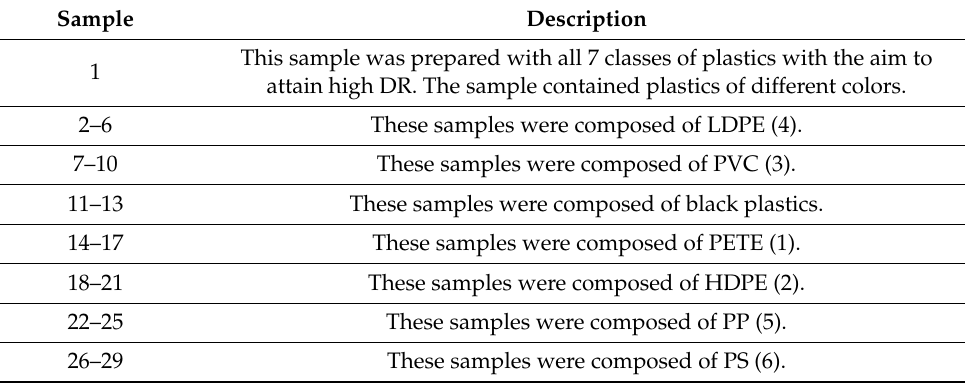
Table 3. Description of polymer samples used in test case